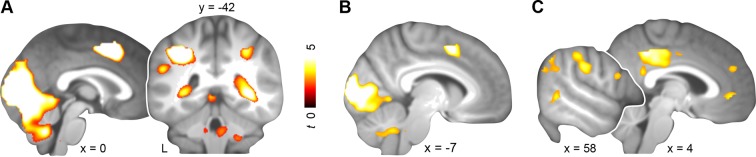
Activation during schema retrieval.(A) Increased BOLD responses during rule-based schema retrieval across both days (schema retrieval > perceptual baseline), (B) during rule-based schema retrieval on day 1 (day 1 > day 2), and (C) after an initial consolidation of 24 hours (day 2 > day 1). Contrasts B and C include runs 5 to 7 from day 1, and the first run from day 2. For display purposes, results were resliced to a voxel dimension of 0.5 mm isotropic and are shown at P < 0.001, uncorrected. Significant clusters are noted in Table 1. Results are superimposed onto the average structural scan derived from all subjects. L–left.